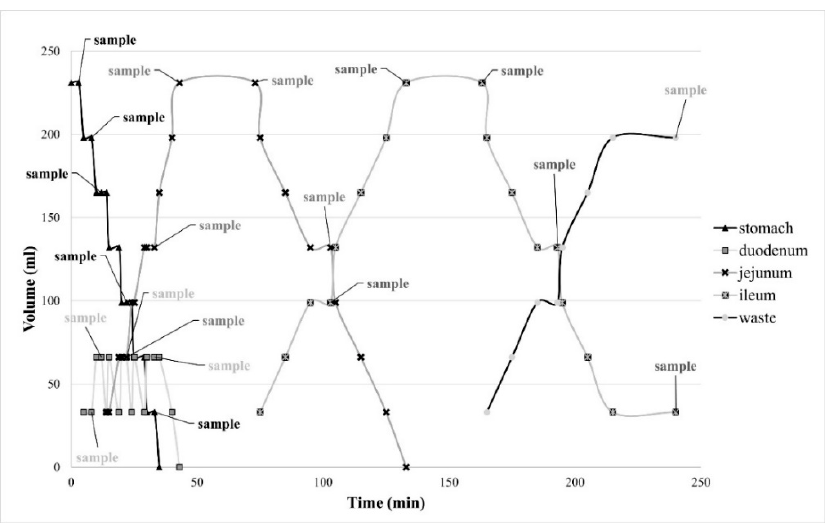
Figure 2. Template diagram with predetermined volume movement and sampling points.